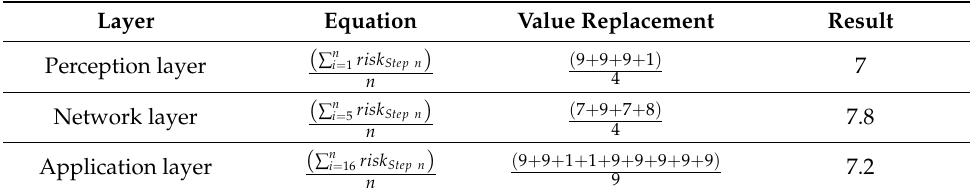
Table 16. Attack surface.